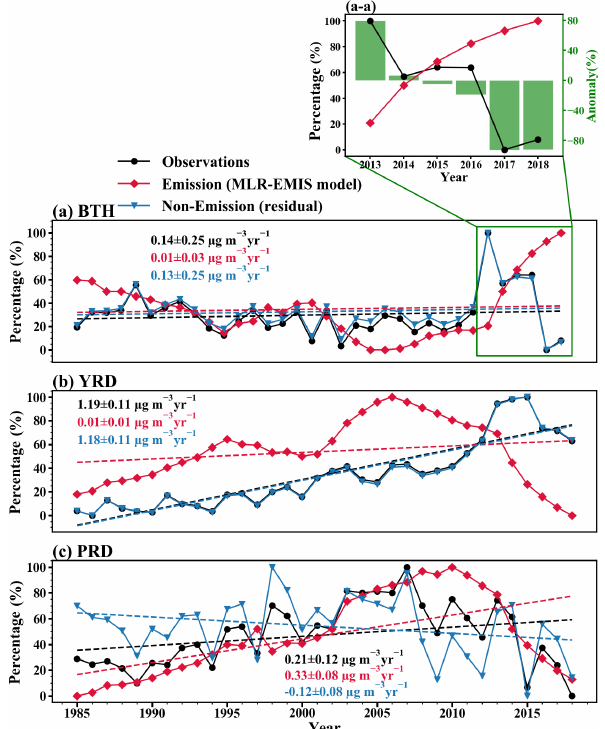
Figure 4. The same as Fig. 2 but for time period of 1985–2018. Panel (a-a) shows enlarged schematic representations of the period 2013–2018 in panel (a)